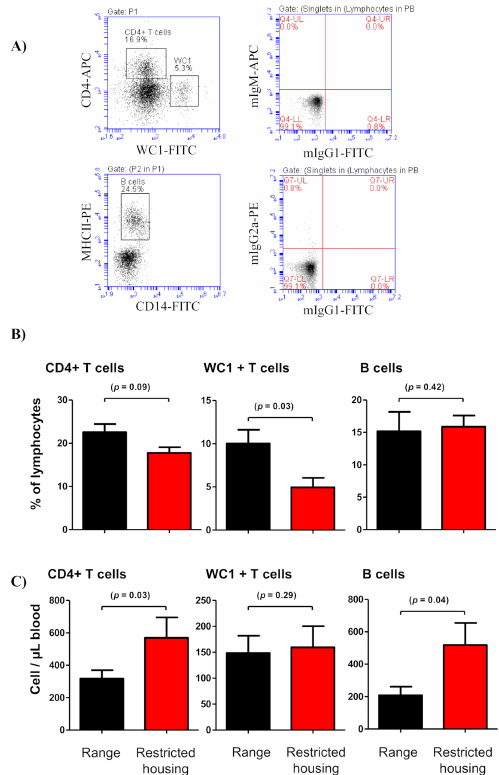
Figure 4. Lymphocyte composition in blood collected from free-range and housed camels. ( A ) Gating strategy for the identification of lymphocyte subsets. The whole lymphocyte population was identi- fied within the mononuclear cells in an SSC-A/FSC-A dot plot and the fraction of CD4-positive T helper cells and WC-1-positive gamma delta ( γδ ) T cells were identified according to their positive staining with CD4 and WC-1 antibodies, respectively. B lymphocytes were defined based on positive staining with MHC-II molecules and negative staining with CD14 antibodies. The relative percent- ages ( B ) and the absolute cell numbers ( C ) of B cells, helper T cells, and γδ T cells were estimated and are presented as mean ± SEM. The p -values indicating the significance of the differences between means are presented for each